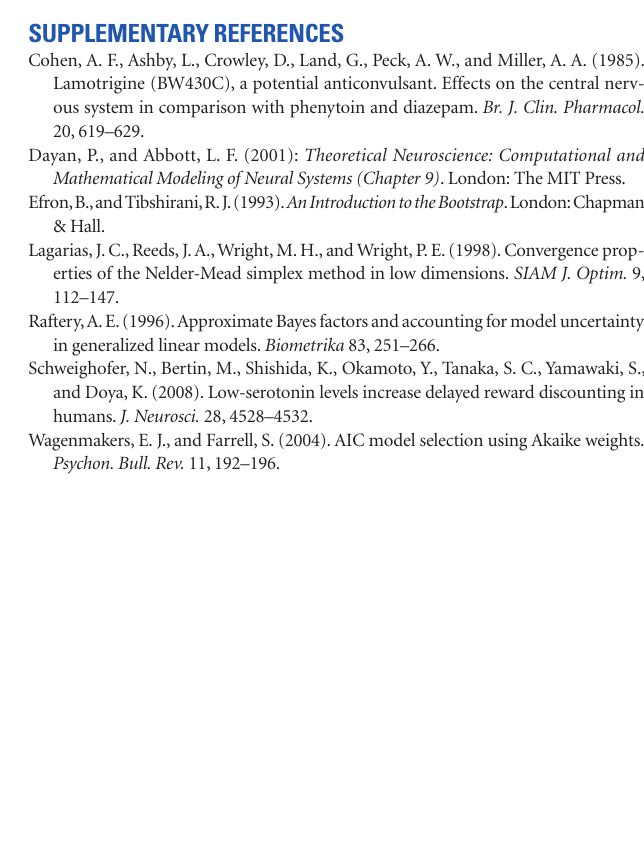
The trend for a slower decay rate in the citalopram group may be